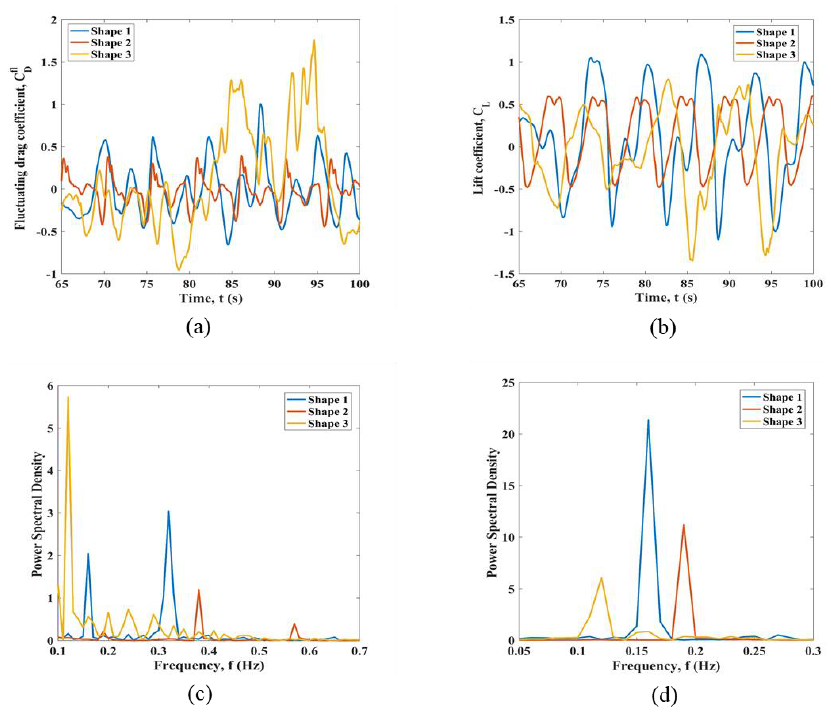
Figure A16. Fluid force coefficients for cylinder 2 immersed in planar sheared flow: ( a ) time history of the fluctuating drag coefficient; ( b ) time history of the lift coefficient; ( c ) the fluctuating drag co–efficient FFT; ( d ) the lift coefficient FFT.